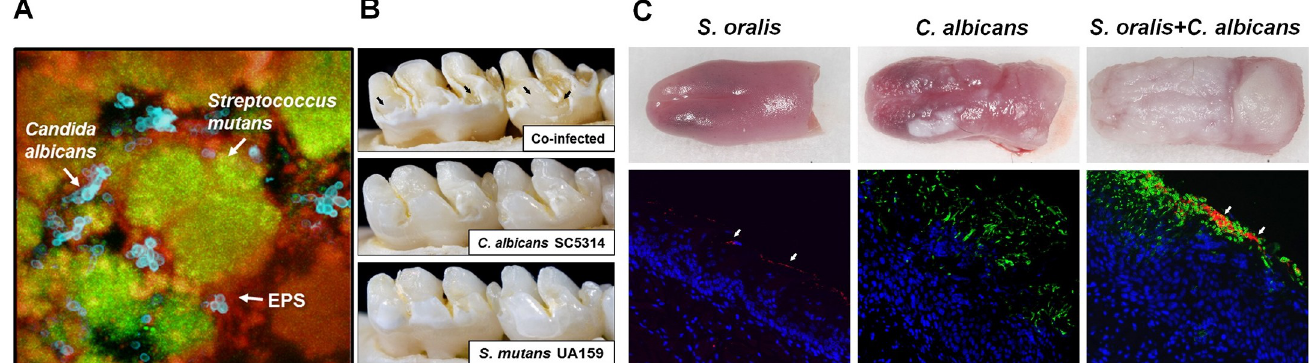
Fig 1. Candida –streptococcal interactions and oral diseases. A. Confocal fluorescence microscopy images of C . albicans – S . mutans mixed biofilms, illustrating the spatial relationship between C . albicans (blue), S . mutans (green), and exopolysaccharides (red). B. Images of teeth from rats infected with S . mutans , C . albicans , or coinfected. Black arrows indicate severe carious lesions of coinfections in which enamel is missing, which exposes underlying dentin. Such rampant caries was absent in the animals infected by S . mutans or C . albicans alone. C. Fluorescence microscopy images of harvested mouse tongues infected with S . oralis (red, see arrows), C . albicans (green), or both. Coinfection substantially increased bacterial–fungal biofilm accumulation, soft tissue invasion, and inflammatory response. Original images provided by Dr . Anna Dongari-Bagtzoglou; adapted from Sobue T . and colleagues , Methods Mol Biol. 1356 : 137–52 , 2016 , with permission . EPS,